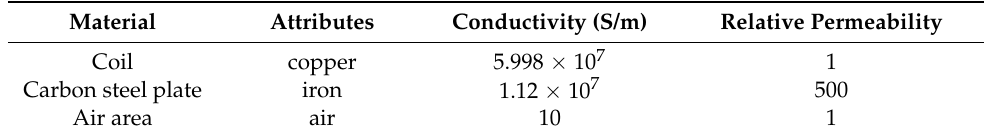
Table 2. The material parameters of the simulation model.